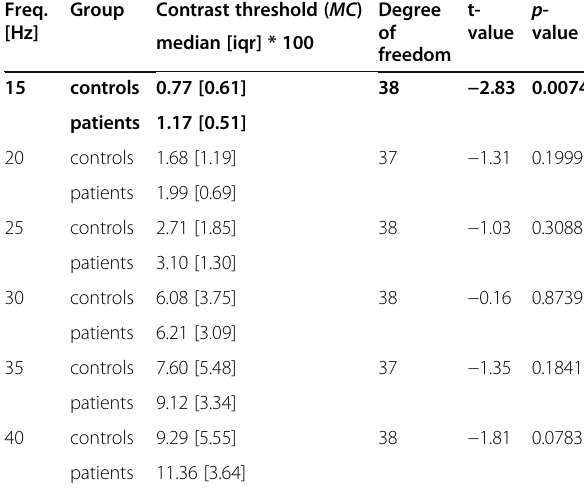
Table 1 Descriptive statistics of the contrast threshold (Michelson contrast): The median and the inter-quartile range of the threshold is shown for each flicker frequency and for both groups. The last three columns show the results of the unpaired t-test of the log 10 (contrast threshold) between patients and controls. Significant differences are marked in